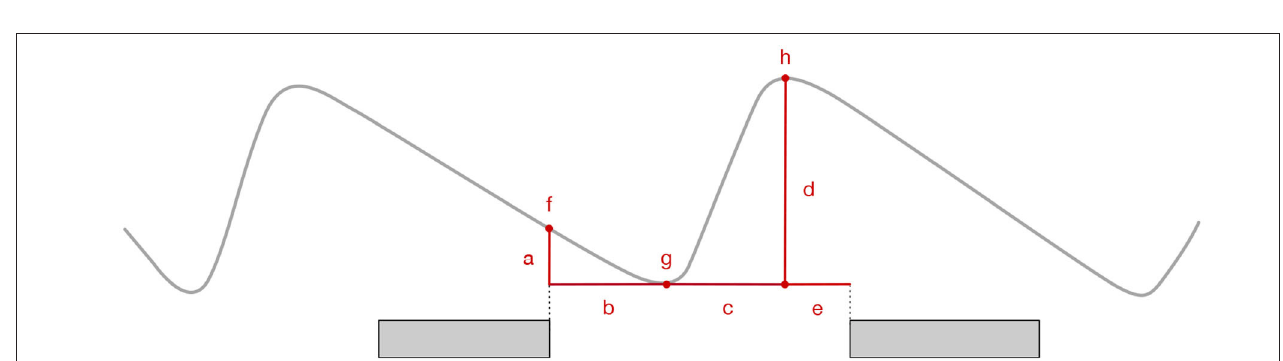
FIGURE 3 | Interactional intervals classified with respect to presence of speaker change, overlapping speech and inhalation in the previous speaker’s respiratory pattern.